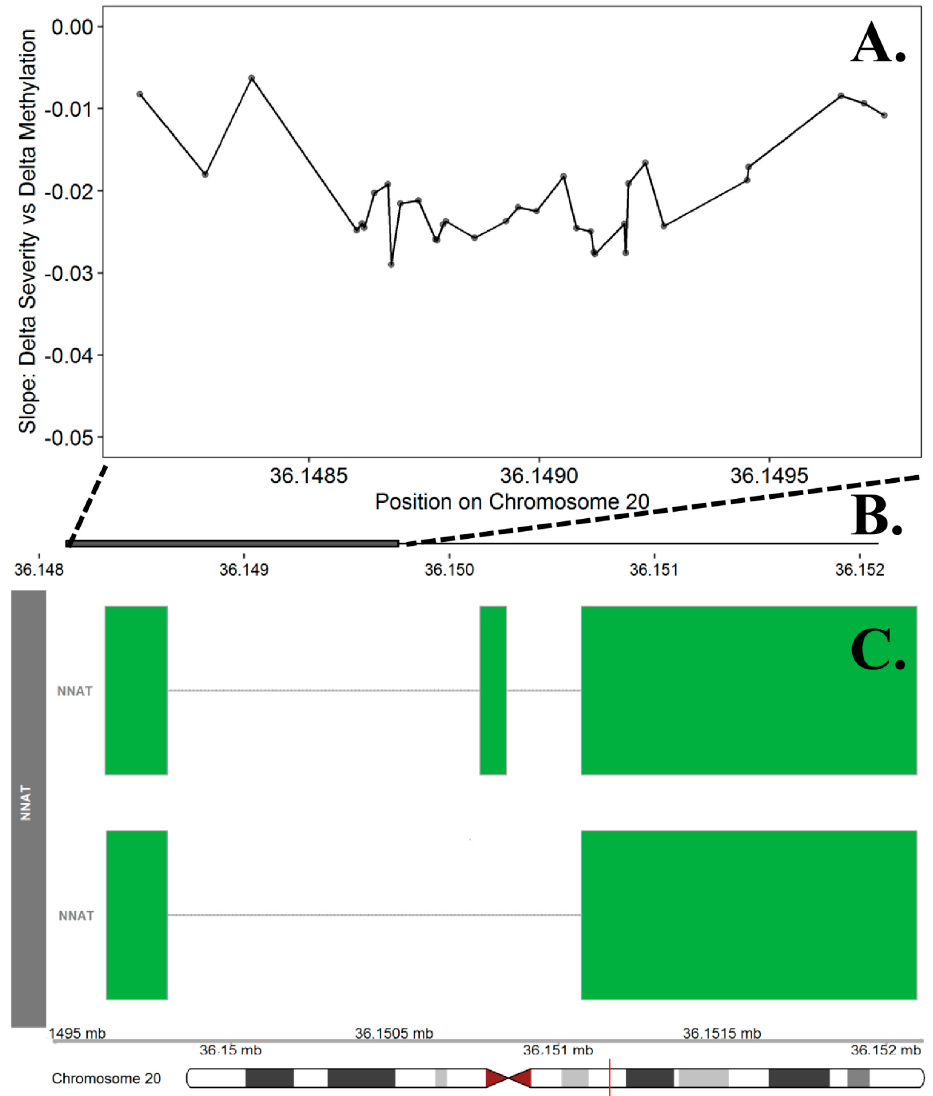
Figure 5. Differentially Methylation Region in the NNAT Promoter Region on Chromosome 20. The top panel ( A ) presents the slope estimates from the curve severity analysis that represent the change in methylation between cases and controls per one-degree change in curve severity at each of the 34 probes included in the promoter region for the NNAT gene. This region was the most significant DMR in the curve severity analysis. The X axis represents the position (mb) of the probes. The middle panel ( B ) represents the location of promoter region (solid square) relative to the entire gene, represented in the bottom panel. Multiple known isoforms of the NNAT gene are represented in the bottom panel ( C ), boxes represent exons and lines represent introns. The red line on the ideogram, bottom of the figure, represents location of the region within the